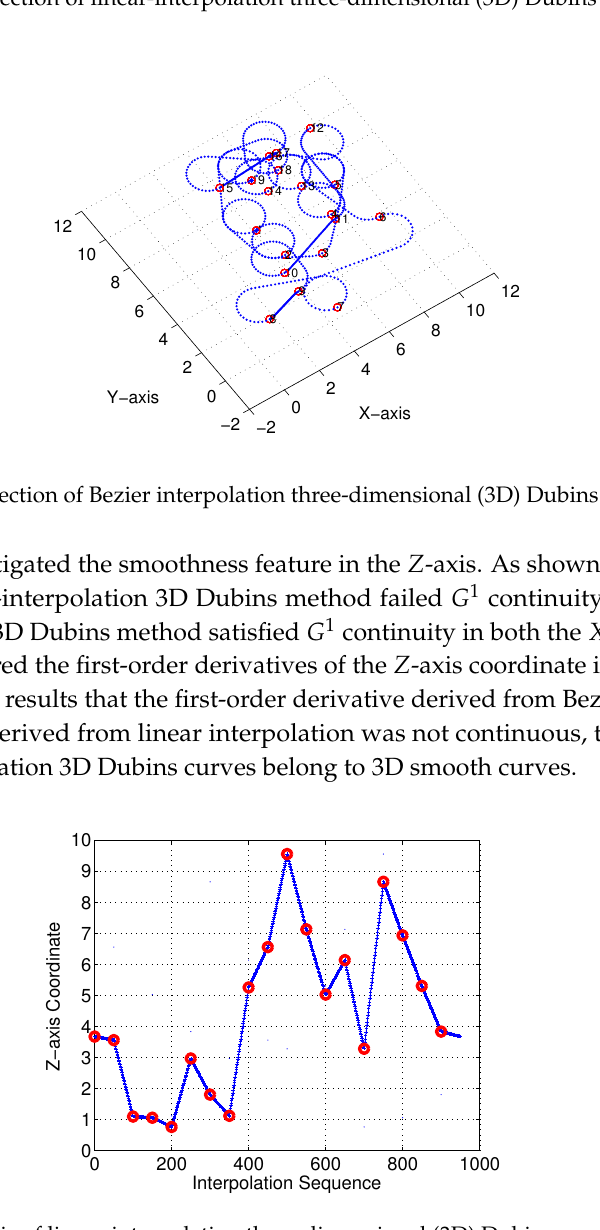
Figure 20. X – Y projection of linear-interpolation three-dimensional (3D) Dubins curves (case 2).